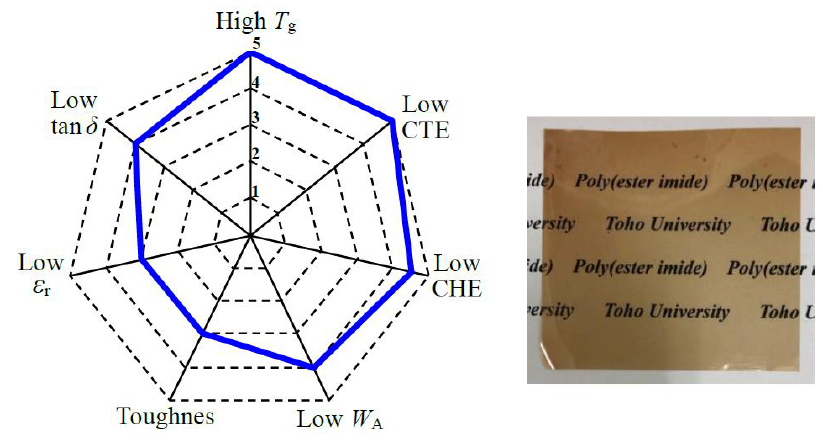
Figure 12. Performance balance for the s-BPDA/AB-MeOHQ system ( #10 ) on the basis of the five-rank criteria (Table 9) and the appearance of the film.